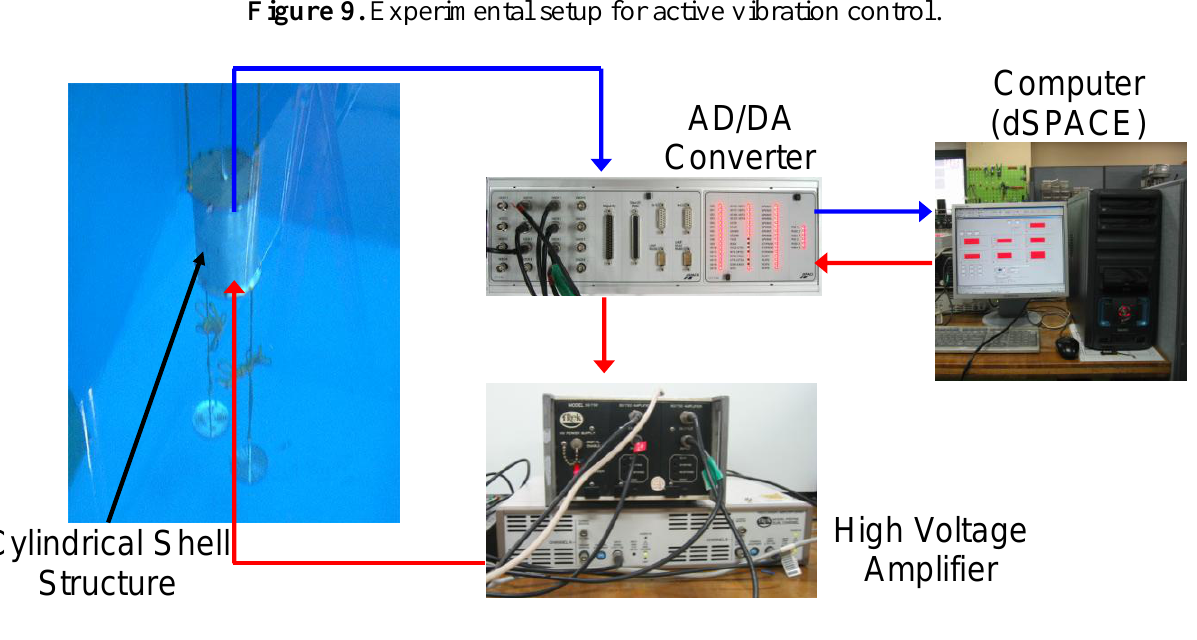
Figure 9. Experimental setup for active vibration